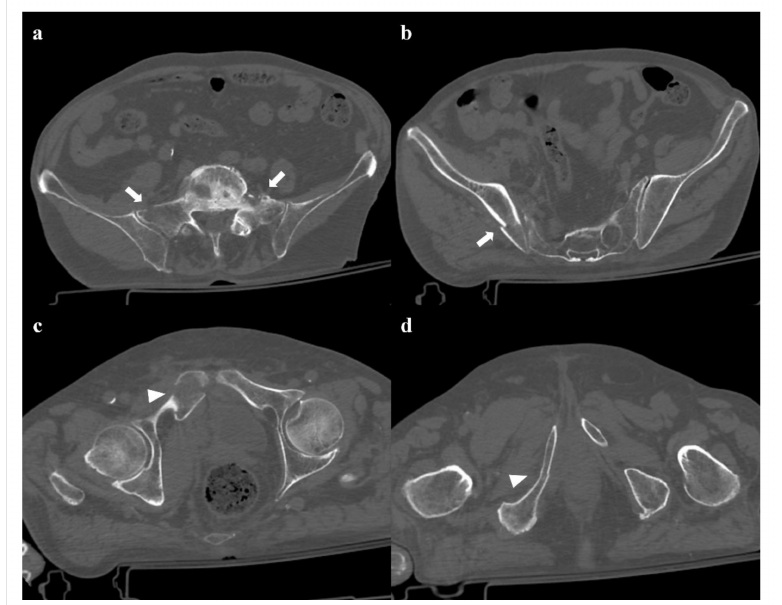
Figure 2. Lateral compression fracture, type 2. Axial CT images show a fracture of both the sacral wings (arrows in ( a )), without the involvement of the neuroforamina (zone I). There is also fracture of the iliac wing on the right side (arrow in ( b )), and ipsilateral fracture of the superior and inferior pubic branches (arrowheads in ( c , d )).